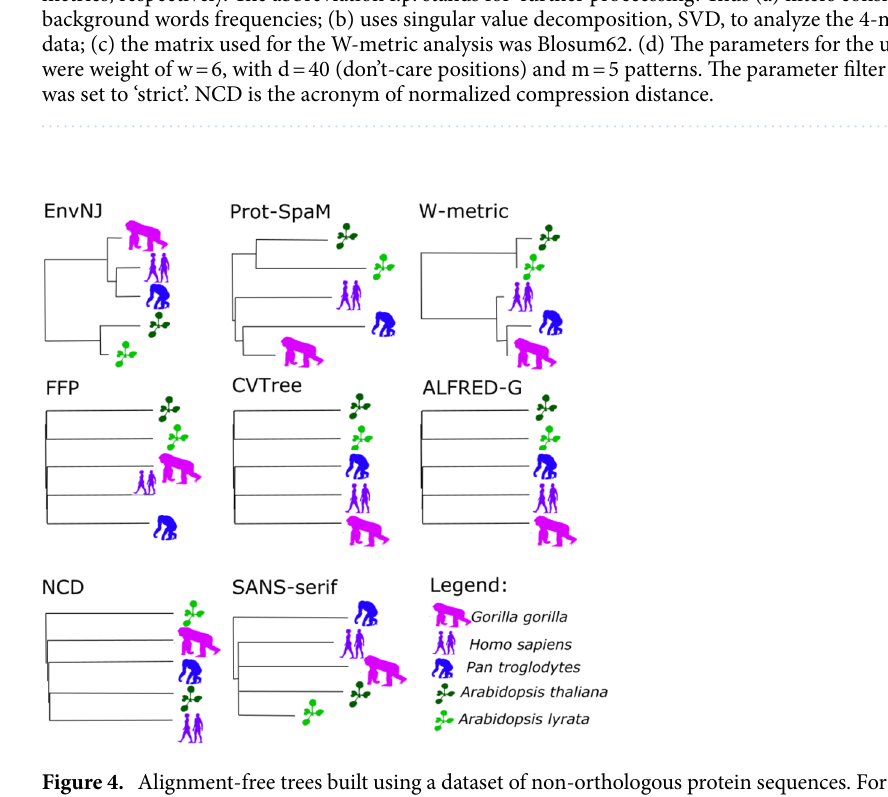
Figure 4. Alignment-free trees built using a dataset of non-orthologous protein sequences. For each species a random set consisting of 180 proteins was selected, with the only restriction that no protein belonging to this set could be homologous to any of the proteins belonging to the remaining species. These random sets of non- orthologous protein sequences were used to generate the corresponding